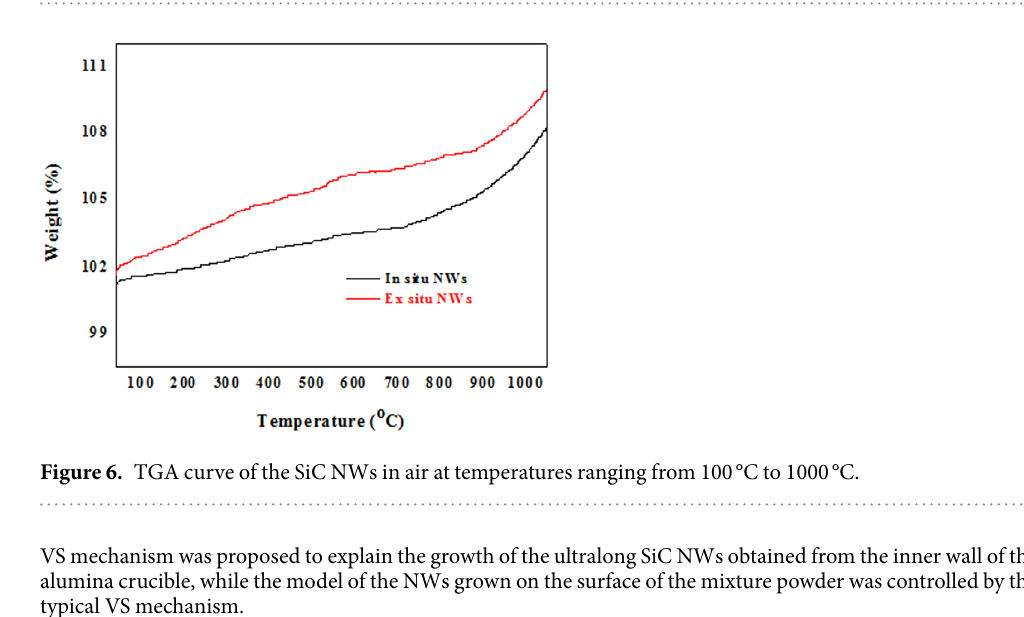
Figure 5. Elemental area scans of the single SiC NWs obtained from the inner wall of the ceramic crucible.